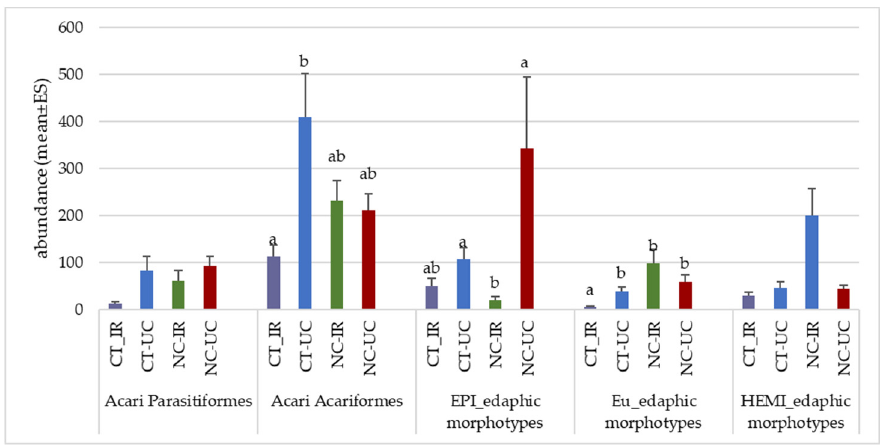
Figure 7. Differences of the five ecomorphotypes abundances in each soil management and position. Mean of the six replicates; different letters indicate significant differences (Duncan’s test; p < 0.05) within the positions and treatments.